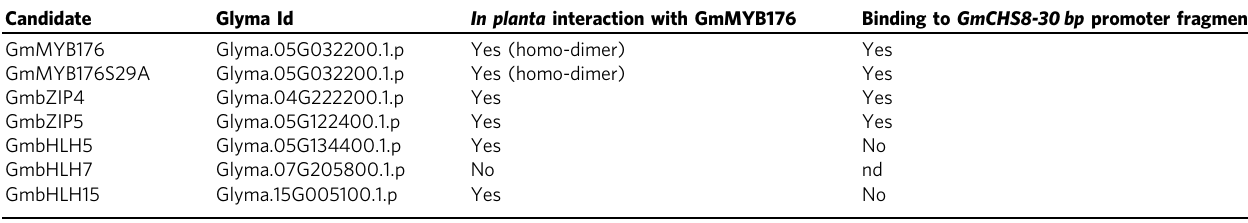
Table 1 Protein – protein interaction and protein – DNA binding activities of GmMYB176 interactome. Candidate Glyma Id In planta interaction with GmMYB176 Binding to GmCHS8-30 bp promoter